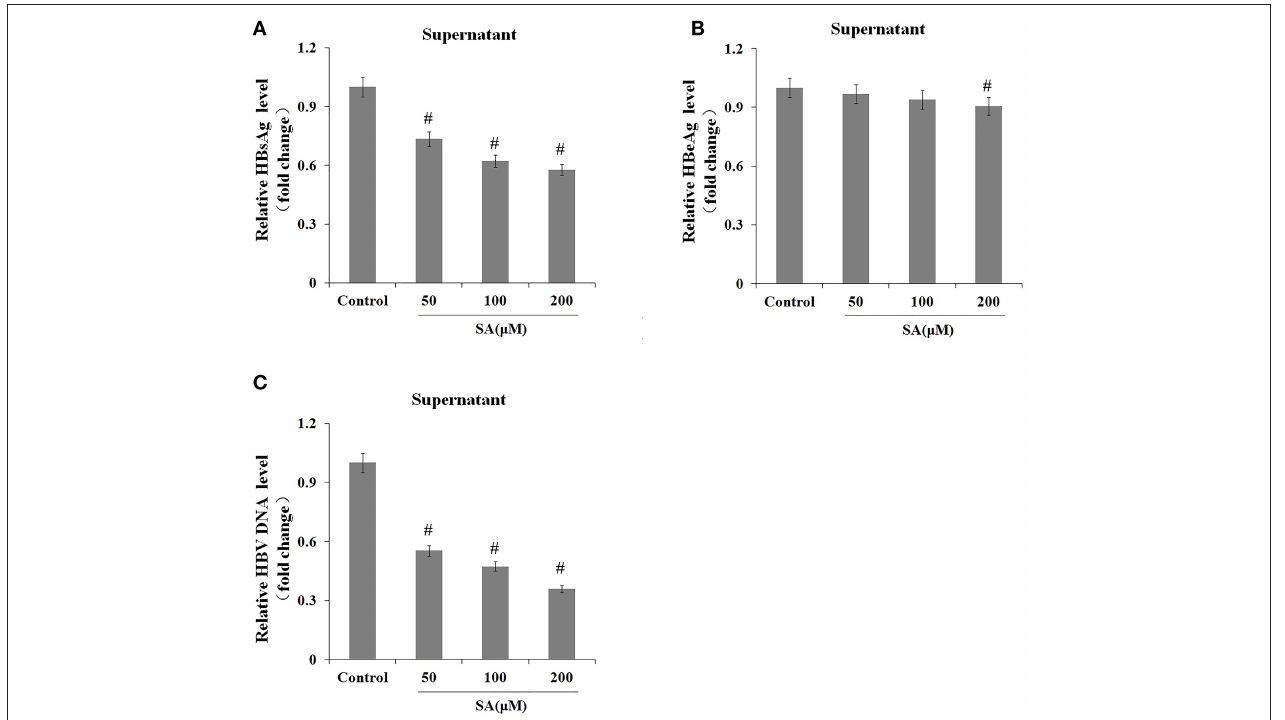
FIGURE 3 | Stearic acid (SA) inhibited the secretion of HBsAg and hepatitis B virus (HBV) DNA in HepG2.2.15 cells. HepG2.2.15 cells were treated with 50, 100, and 200 µ M of SA for 48h. The supernatant levels of HBsAg and HBeAg were determined by ELISA, while those of HBV DNA were determined by qPCR. (A) HBsAg levels as determined by ELISA. (B) HBeAg levels as determined by ELISA. (C) HBV DNA levels as determined by qPCR. The results are presented as fold-changes compared with the control. Histograms represent the means ± SD of three independent experiments. # P < 0.05 vs. the control.